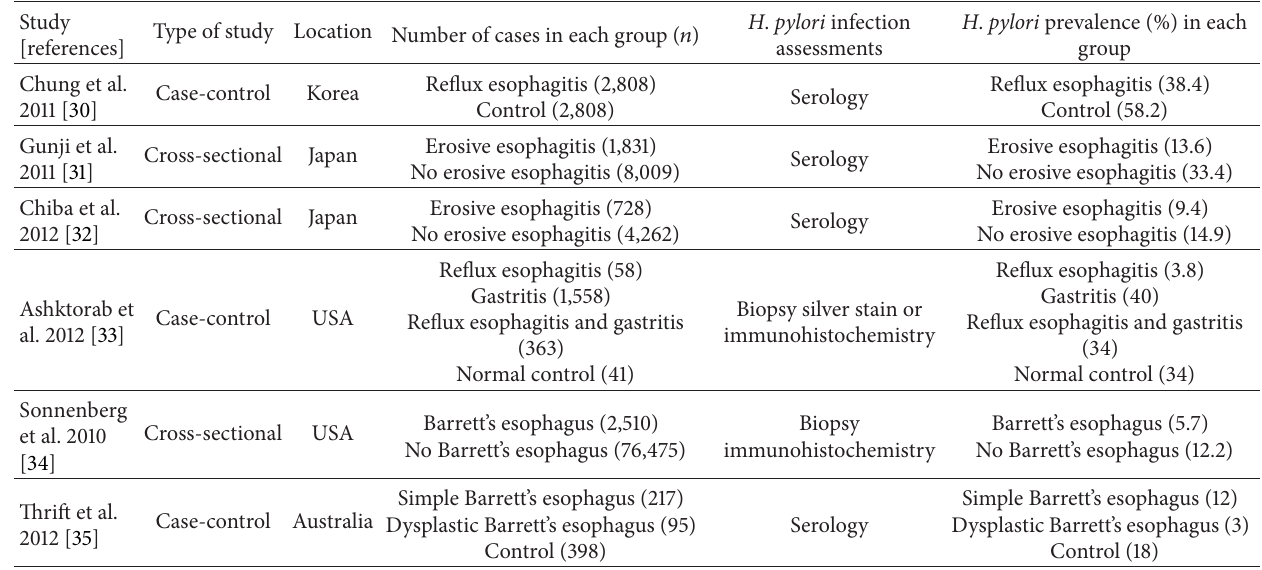
Table 1: Recent epidemiologic studies for association between H . pylori infection and GERD.